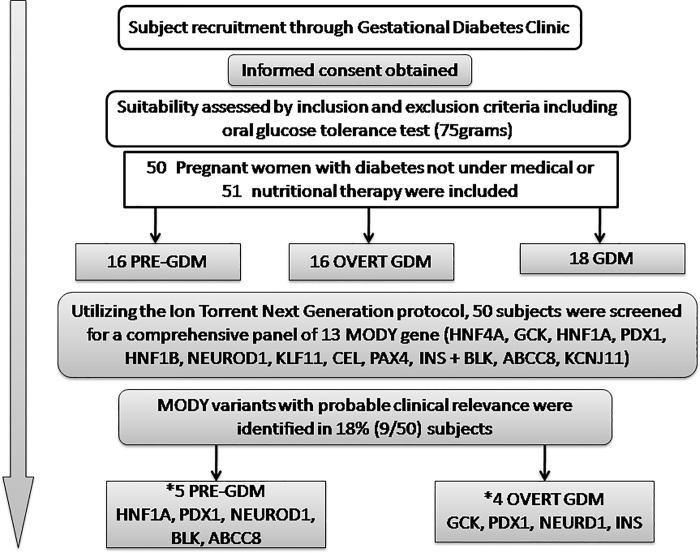
Detailed diagrammatic algorithm of the study with flow chart of NGS screening of the subject.